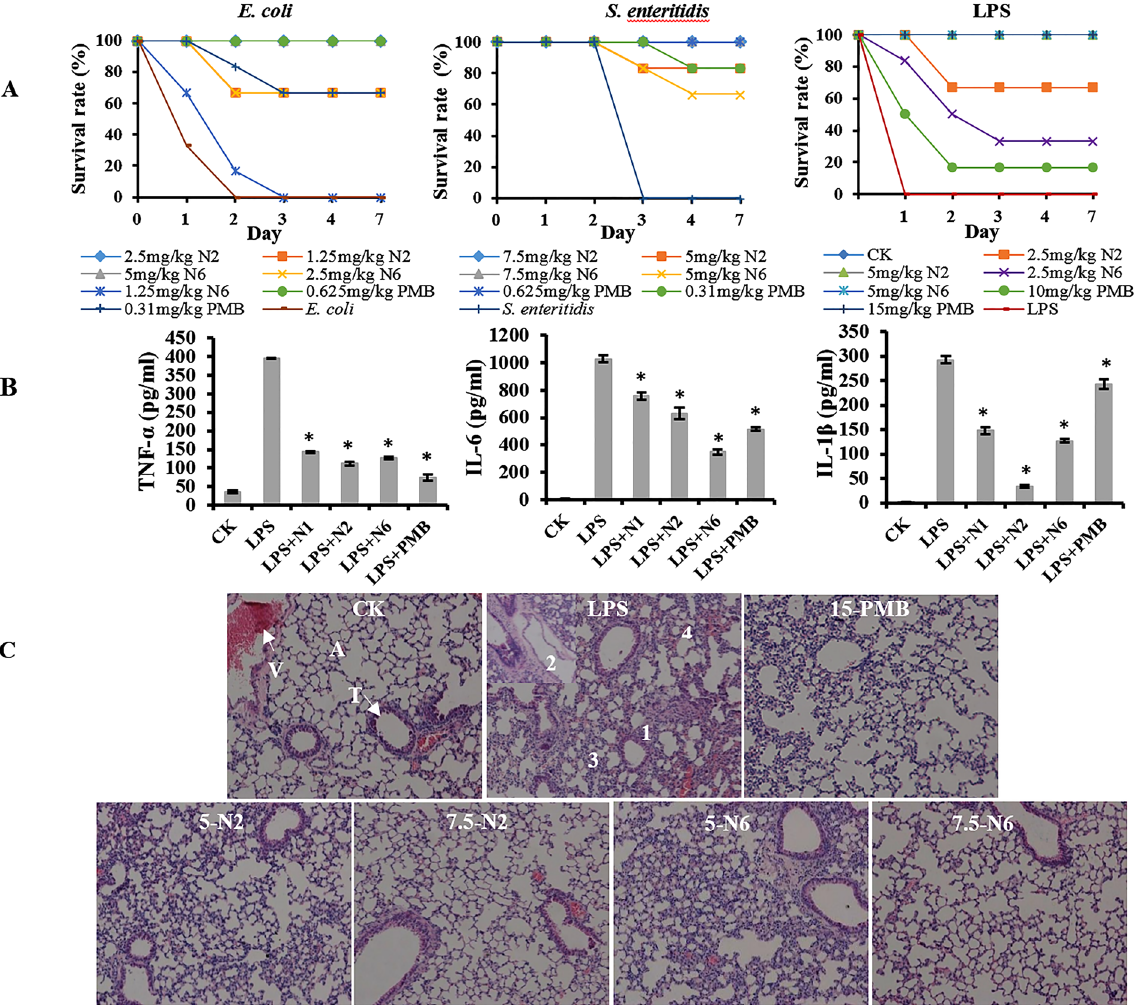
Figure 7. Effect of N2 and N6 on bacteria-induced and LPS-induced responses in vivo . ( A ) Survival of mice treated with N2 and N6 in E . coli , S . enteritidis , and LPS lethal models. Mice were intraperitoneally injected with E . coli (2.5 × 10 8 CFU/ml), S . enteritidis (1 × 10 6 CFU/ml), and LPS (30 mg/kg of body weight), respectively, followed by injection with N2, N6 or PMB at 0.5 and 8 h. Survival was recorded for 7 days. ( B ) Inhibition of LPS-induced cytokine release in C57BL/6 mice by N2 and N6. The results are given as the mean ± SEM. Differences between groups were determined by one-way ANOVA followed by SPSS analysis (n = 3 per group). * p < 0.05 compared to the LPS-treated group. ( C ) Protection of lungs from damage by LPS. Lung specimens were collected from sacrificed mice after LPS injection and treatment. The sections were stained with hematoxylin and eosin. V: vessel; A: alveoli; T: trachea. 1: alveolar septum thickening; 2: pulmonary alveolar collapse; 3: inflammatory cell